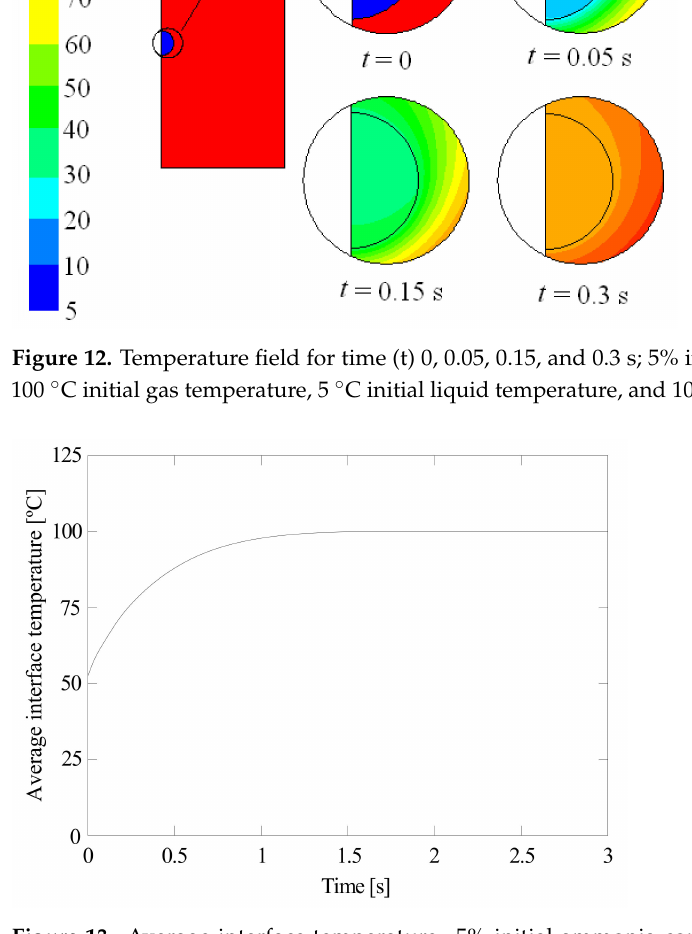
Figure 13. Average interface temperature. 5% initial ammonia concentration, 100 ◦ C initial gas temperature, 5 ◦ C initial liquid temperature, and 1000 µ m initial